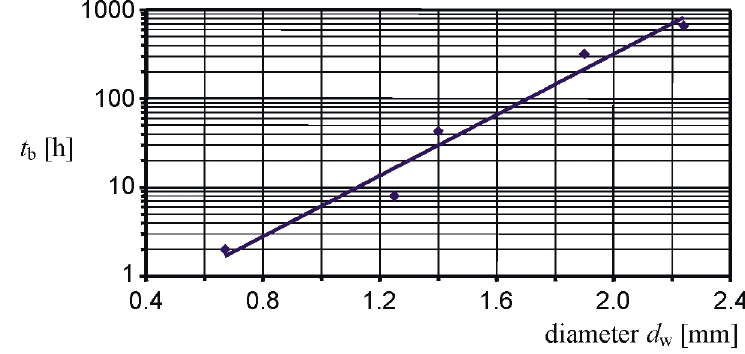
Figure 9. Influence of magnet wire diameter d w on time ‐ to ‐ breakdown t b for the same testing voltage.